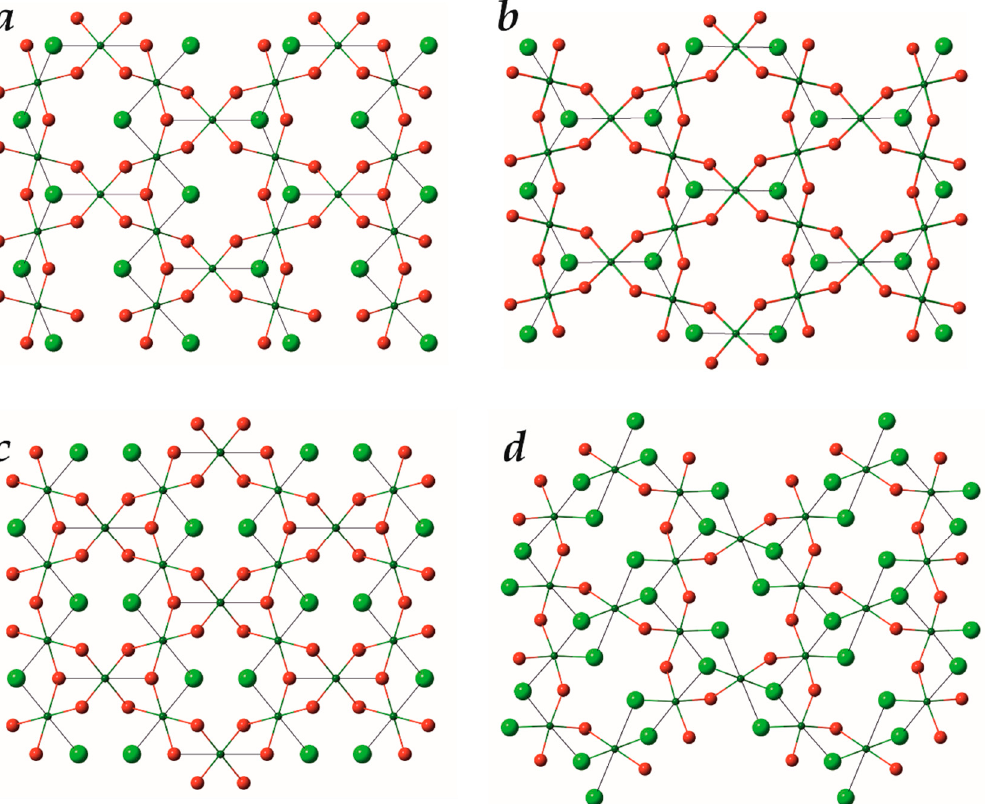
Figure 9. The [Cu 3 φ 8 ] layers ( φ = Cl, OH) in the crystal structures of atacamite (parallel to (011) ( a ); clinoatacamite (parallel to (011) ( b ); bobkingite (parallel to (001) ( c ) and avdoninite (parallel to (100) ( d ). Legend as in Figure 5.